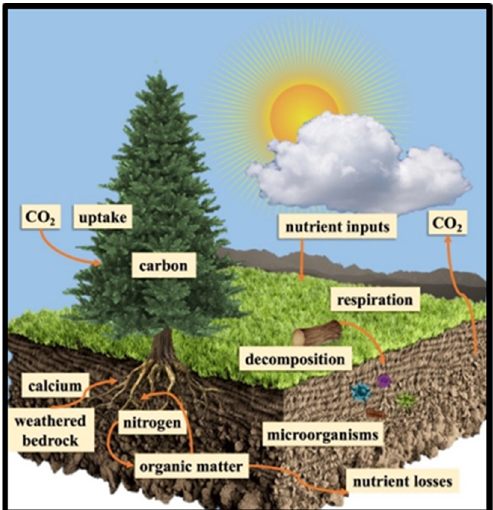
Figure 1. Rehabilitation plays a fundamental role in the host ecosystem. Beneficial factors to the ecosystem include providing oxygen, nutrients, water, and physicochemical support, adopted from Fisher et al. [9].